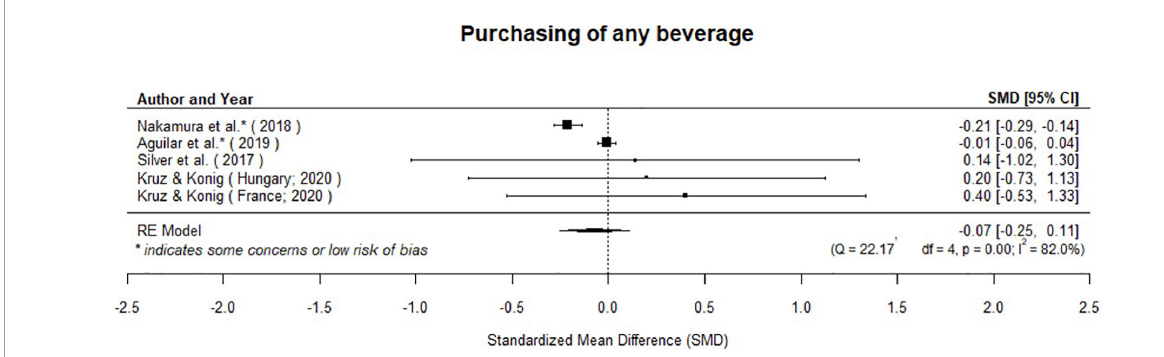
FIGURE4 Taxes on SSBs have no overall effect on purchasing of beverages.